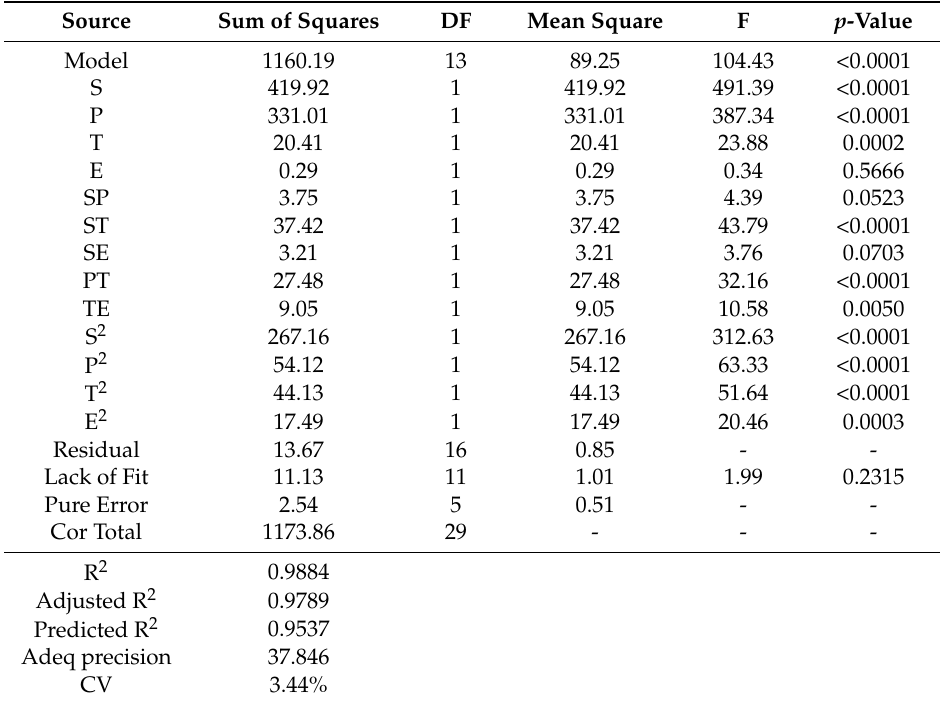
Table 4. ANOVA analysis for response surface quadratic model ( α =